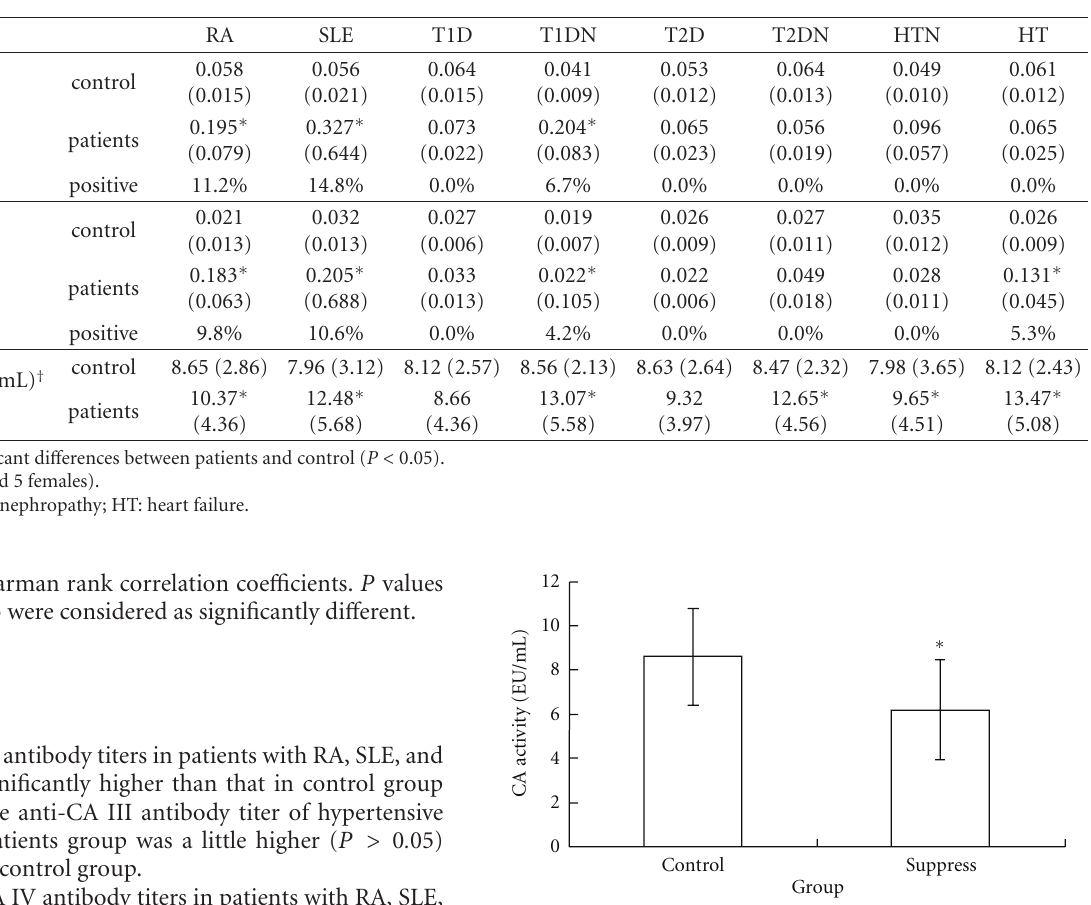
Table 1: The anti-CA III, IV titers, and the CA activity of subjects (mean (SD)).